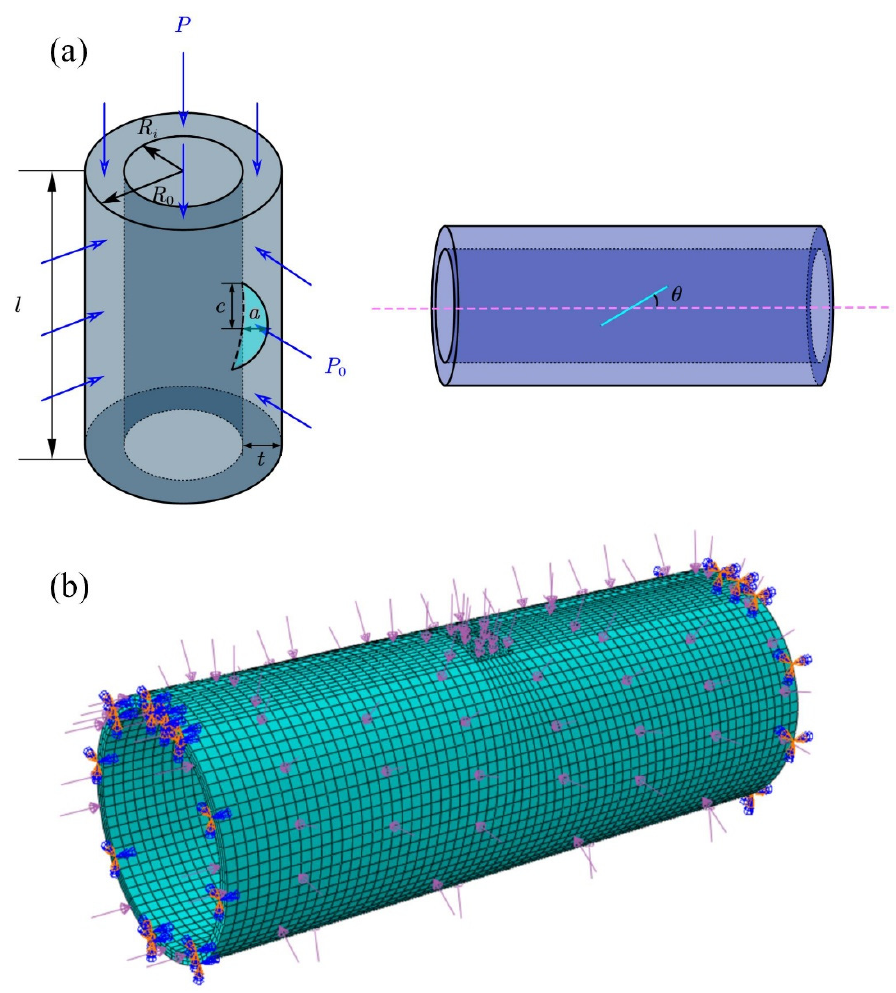
Figure 1. ( a ) Pressure pipe with an inclined crack on the inner surface. ( b ) Loads and boundary